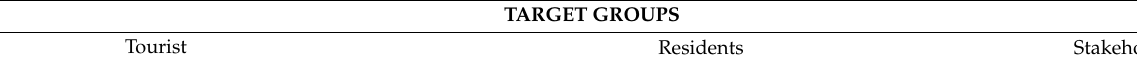
Table 3. Measuring overtourism through interviews: literature